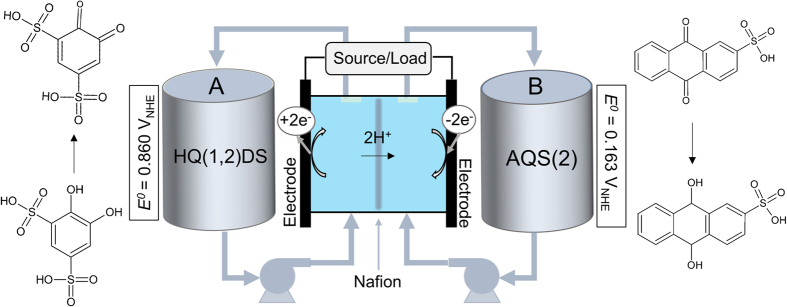
Schematic of an all-quinone RFB during charging13.Quinone species are dissolved in 1 M H2SO4, and the cell potential is 0.7 V. During charging each quinone stores 2 electrons while at the same time 2 H+ are exchanged through Nafion.